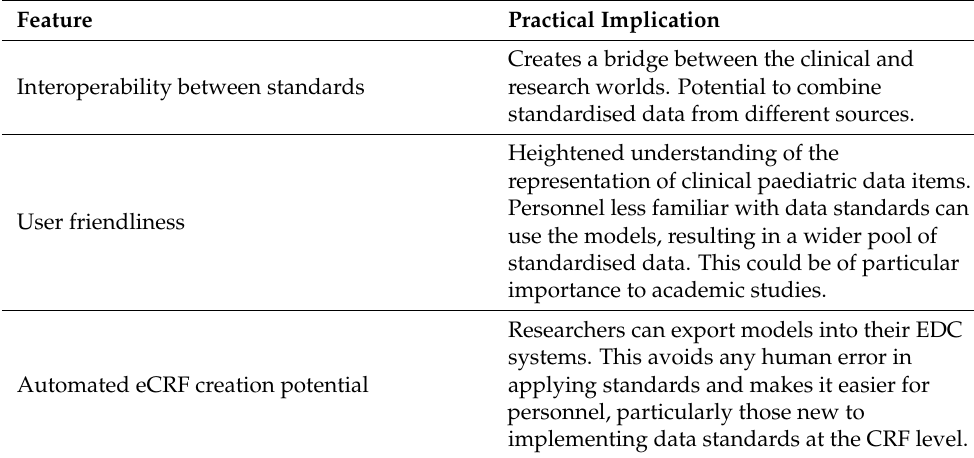
Table 2. Implications of the clinical modelling